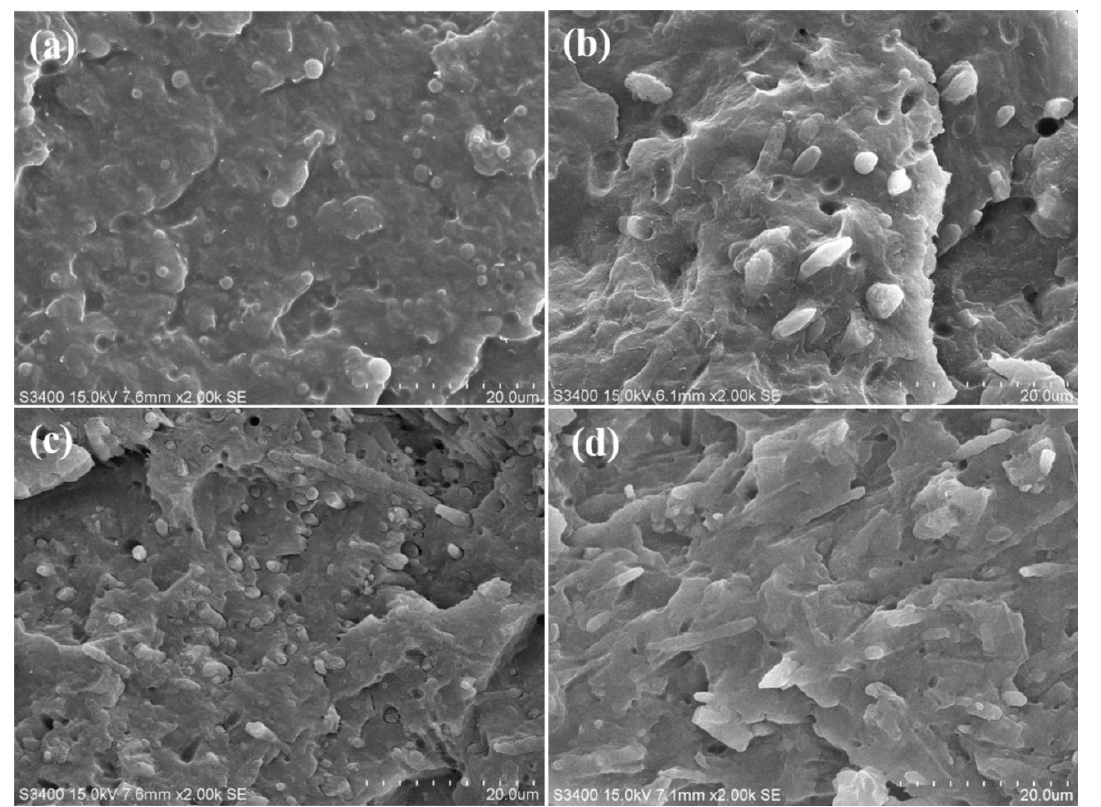
Figure 1. SEM micrographs of the carbon black (CB)/PA6/PP (3 vol% CB) composites with different stretch ratios: ( a ) λ = 1, ( b ) λ = 5, ( c ) λ = 10, ( d ) λ = 15.